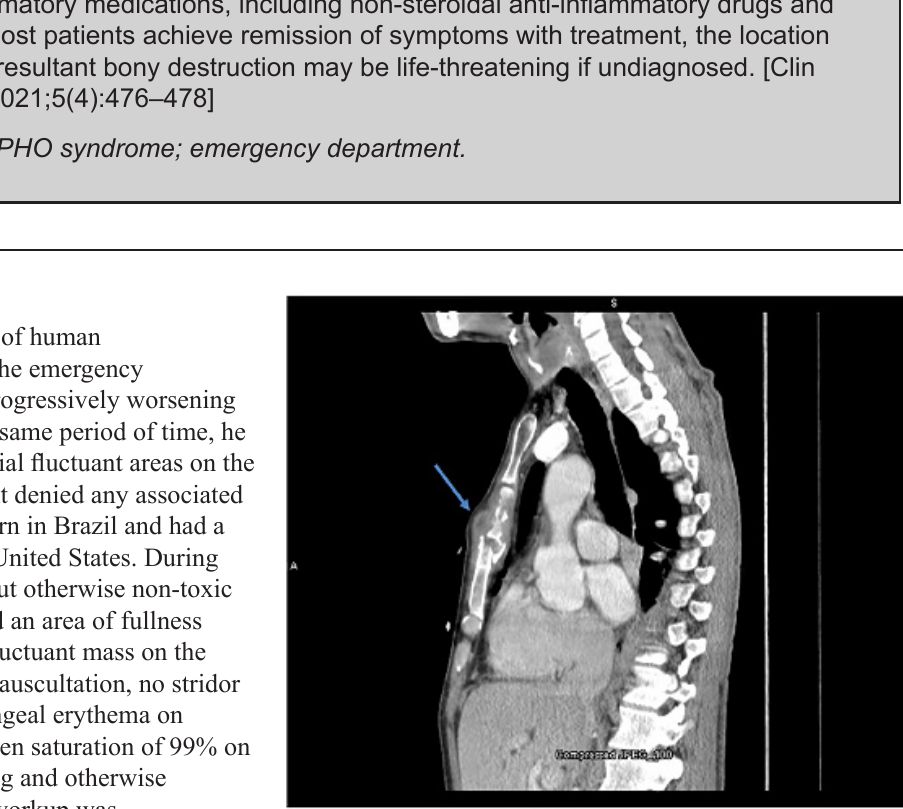
Image 1. Computed tomography of the chest with contrast (sagit- tal view) showing fluid enhancing mass overlying the sternum with bony destruction of the sternum (blue